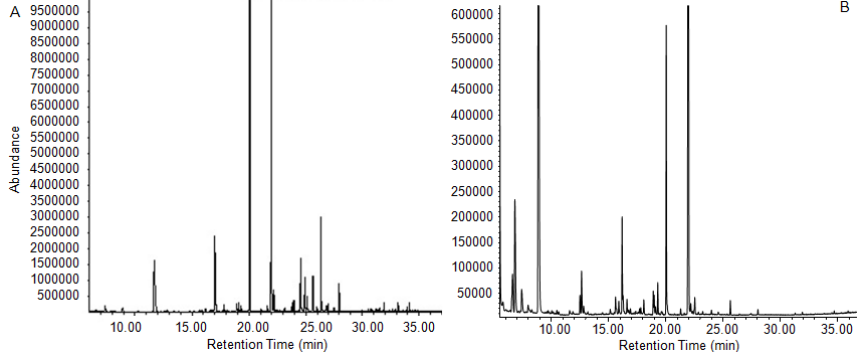
Figure 3. GC/MS chromatogram of essential oil from fermented media ( A ) and a fresh external layer ( B ) of cultivated sclerotium of P. cocos. Table 2. Compounds identified in the essential oil extract of culture media and fresh external layer of cultivated sclerotium of P. cocos .